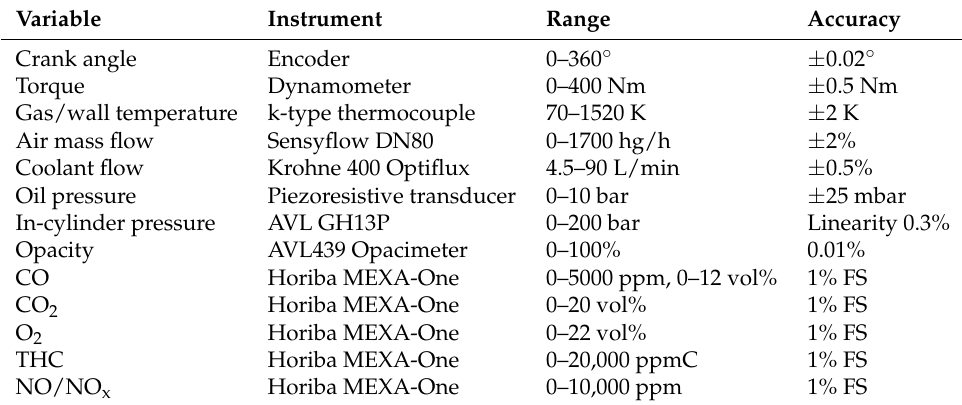
Table 2. Test cell instrumentation.